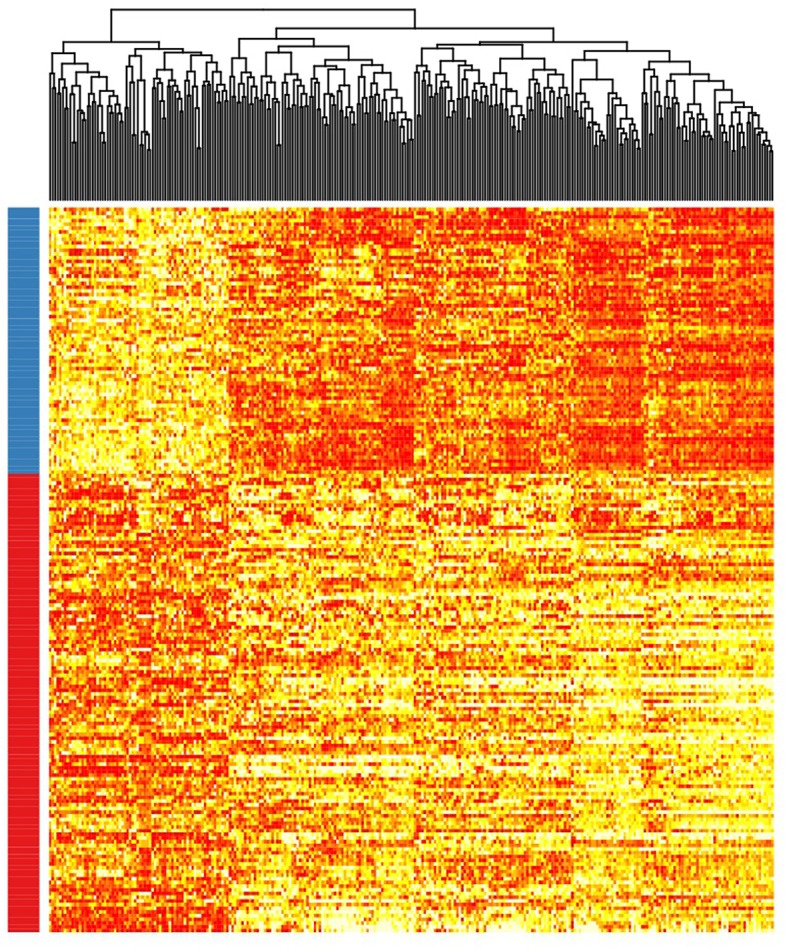
Heatmap showing the rank-transformed distribution of expression values for the 290 genes in the study cohort. Red-labeled samples on the left bar petain to C1 and blue-labeled samples pertain to C2.